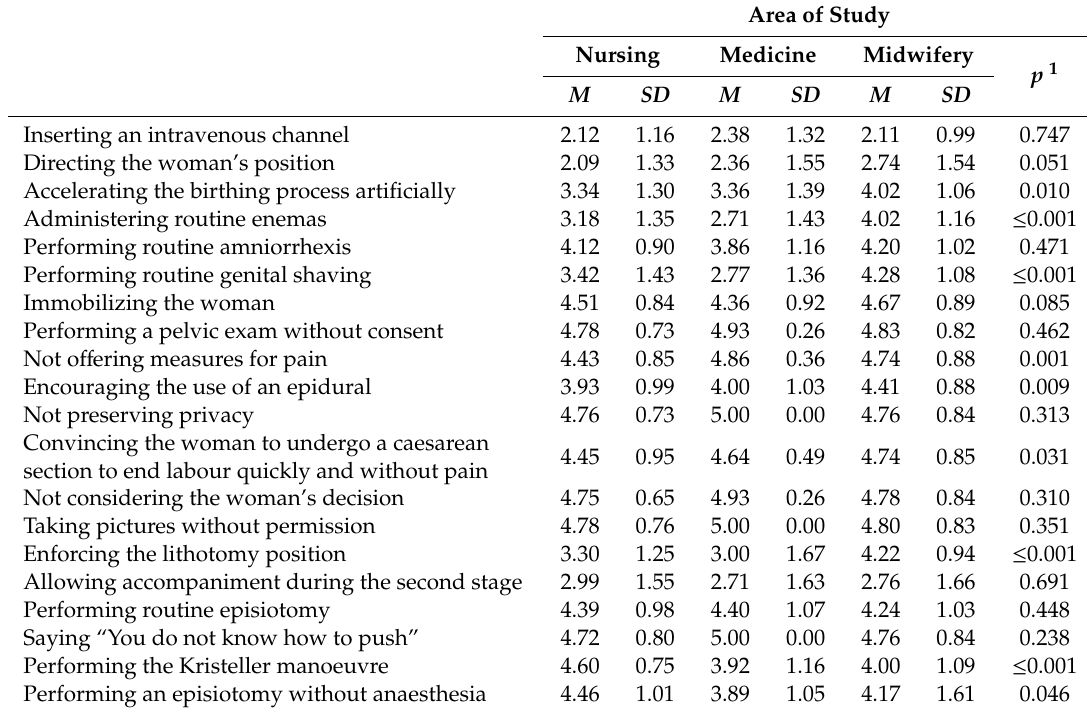
Table 4. Descriptive and comparative results of the area of study and PercOV-S